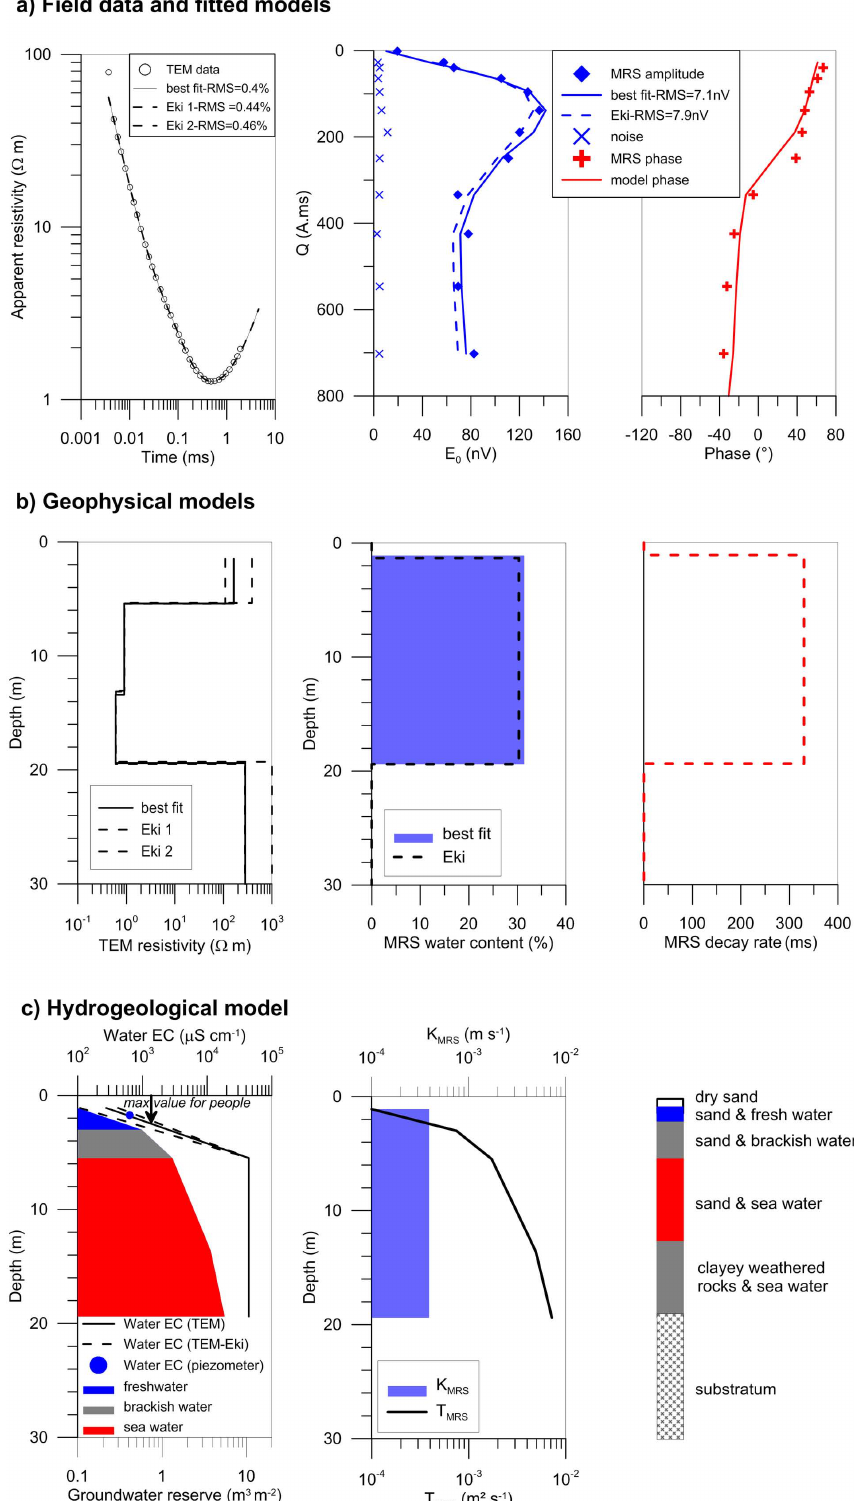
Fig. 6. 1-D application of the hydrogeophysical methodology. (a) MRS6 and TEM66 data and fitted models. (b) Geophysical models. (c) Hydrogeological interpretation. Eki are the calculated equivalent